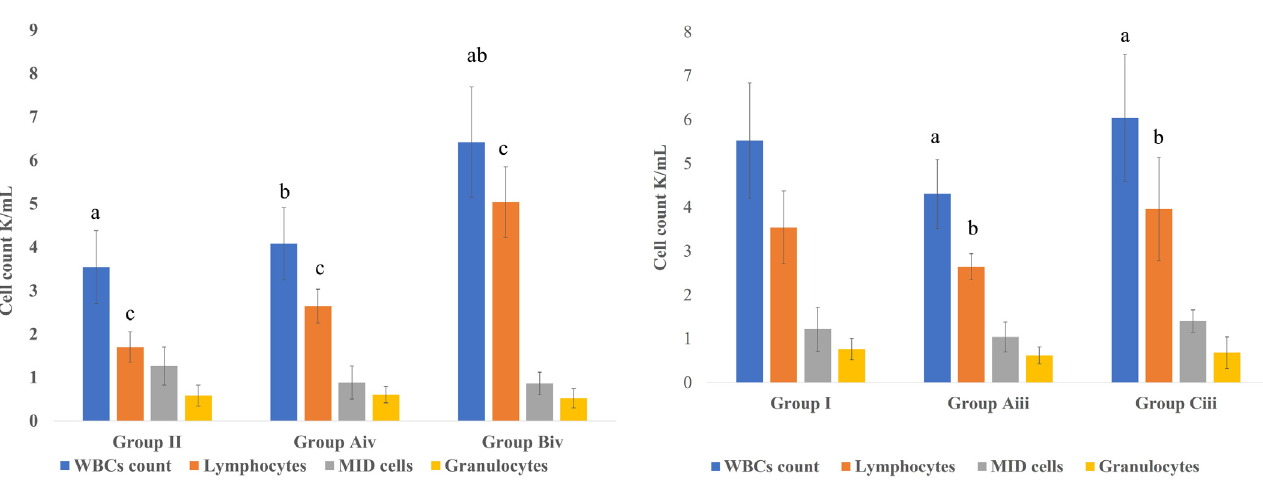
Fig. 9. A chart shows WBCs count results (mean ±standard deviation) of subgroups treated with 7,12-dimethylbenza[a]anthracene (DMBA) for 6 weeks then, Nigella Sativa (Aiv) or Thymoquinone (Biv) for 6 weeks as compared to each other and to DMBA-treated group (GII). MID: Less frequently occurring cells such as monocytes, eosinophils, basophils and other precursor white cells. abc Indicate that a signi fi cant difference ( P value < 0.05) exists between compared sub/ groups that are marked with the same letter.